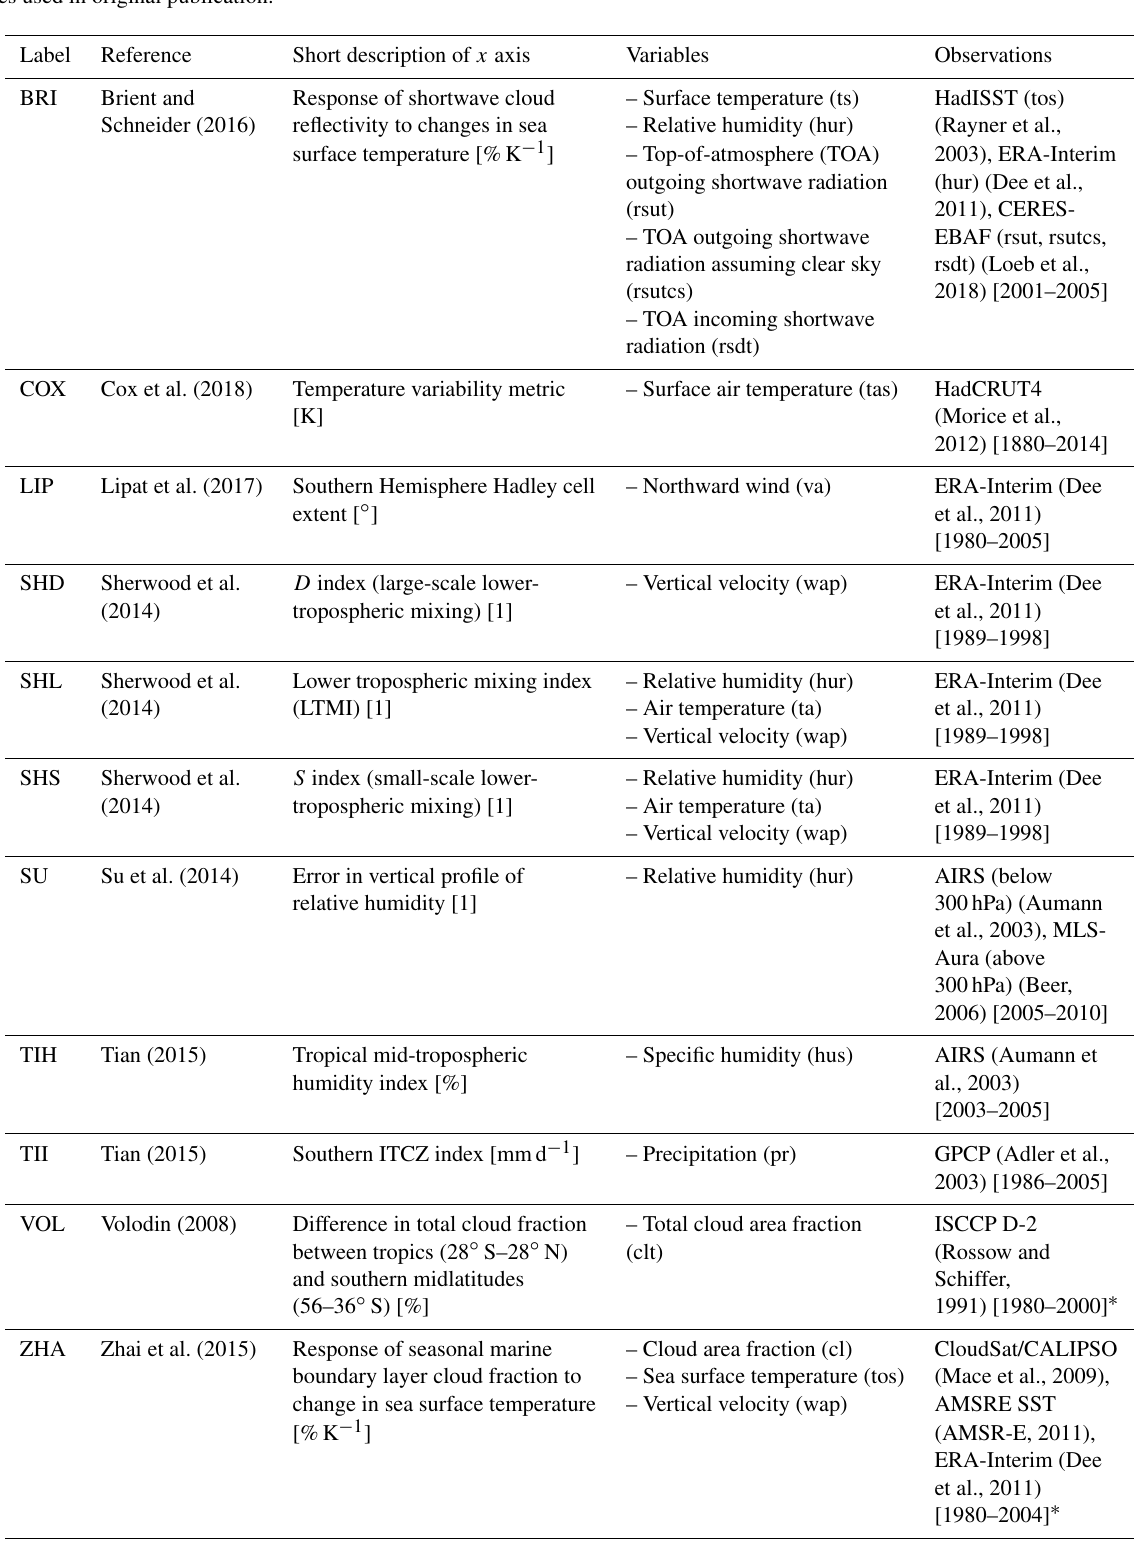
Table 1. Overview of the 11 emergent constraints on the ECS used in this study. Observations marked with an asterisk ( ∗ ) are identical to the ones used in original